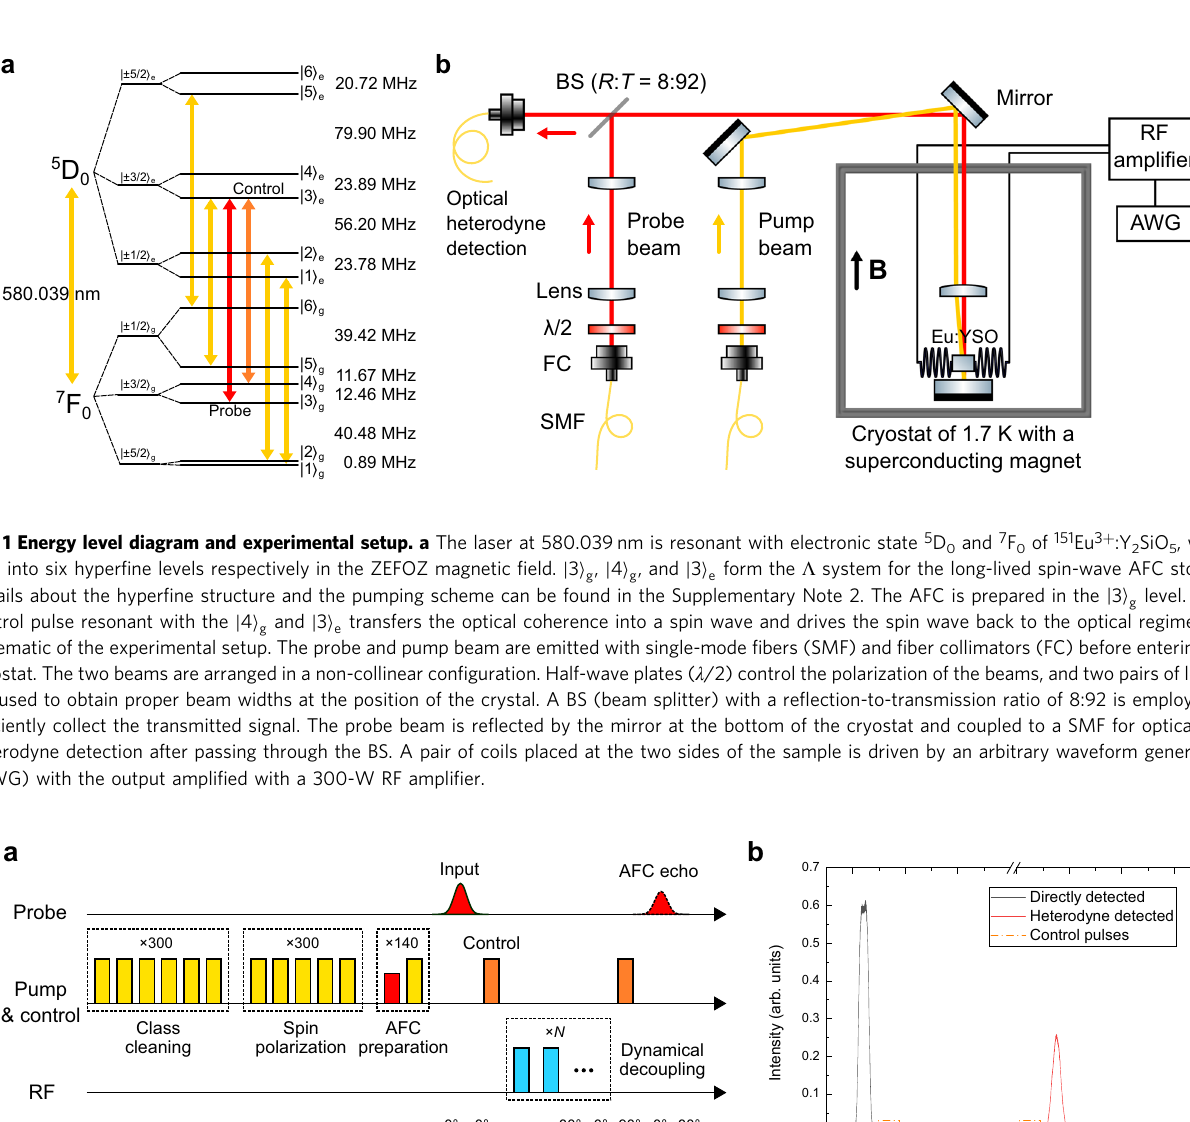
second control pulse transfers the spin coherence back to the optical excitation. The collective state will continue rephasing and emits an AFC echo when the excited-state storage time reaches 1/ Δ = 10 μ s. Two kinds of DD sequences, i.e., CPMG and KDD x , are used to protect the spin coherence in our experiments. As shown in Fig. 2a, each of them consists of sequences of π pulses with different phase shifts, where τ is the spacing between the center of the π pulses. As a comparison with the optical storage times, the spin coherence times with DD are also measured using RHD (see